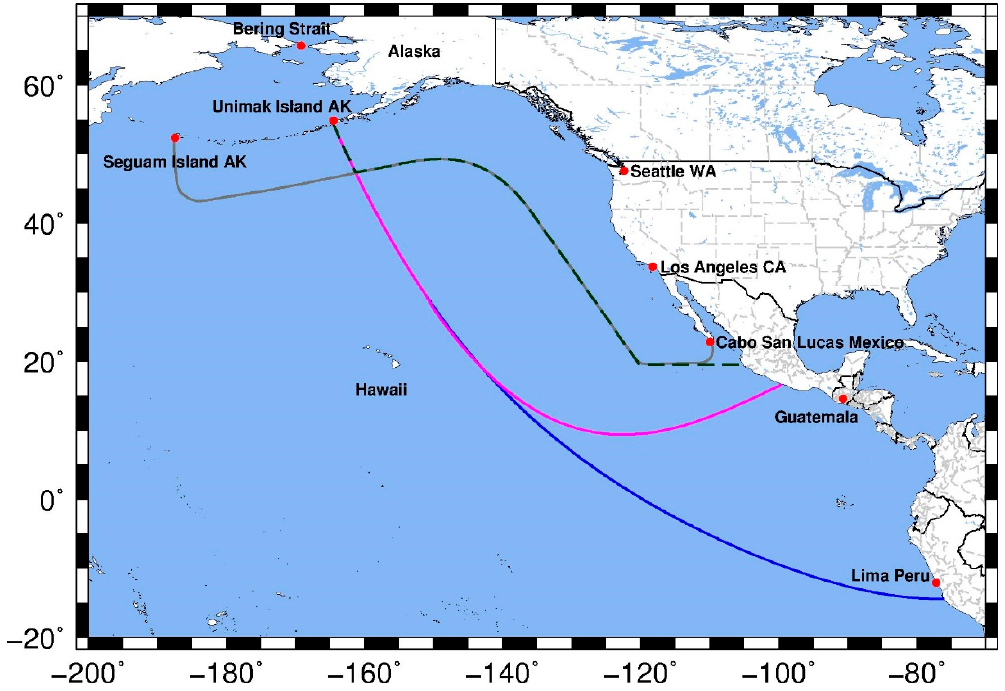
Figure 1. Location of current and historical tidal databases within the Eastern North Pacific region: ENPAC1994 (blue), ENPAC02 (magenta), ENPAC03 (dashed dark green) and ENPAC15 (gray).